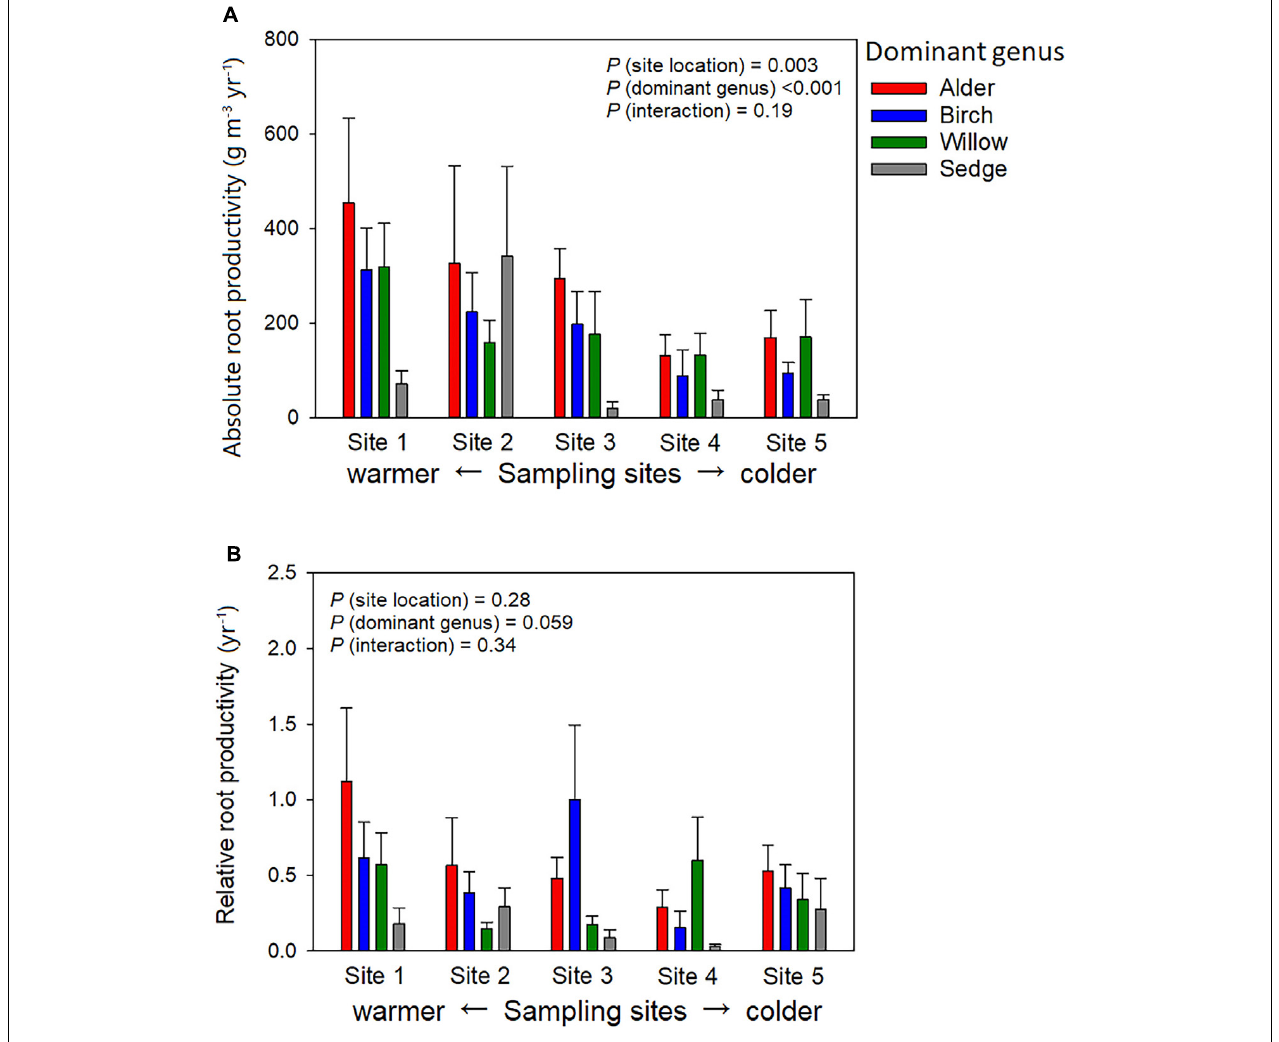
FIGURE 4 | Community-level productivity of absorptive roots among four different vegetation types in absolute (A) and relative (B) manner. Absolute root productivity was the averaged biomass in the ingrowth cores, whereas relative root production was the ratio of absolute root production to the averaged initial root biomass before the root ingrowth experiment. Absolute root productivity was influenced by site location ( P = 0.003, Sites 1, 2 > Site 4, Site 2 > Site 3) and dominant genus ( P < 0.001, Alder, Birch, Willow > Sedge). Relative root productivity was only marginally influence by dominant genus ( P =